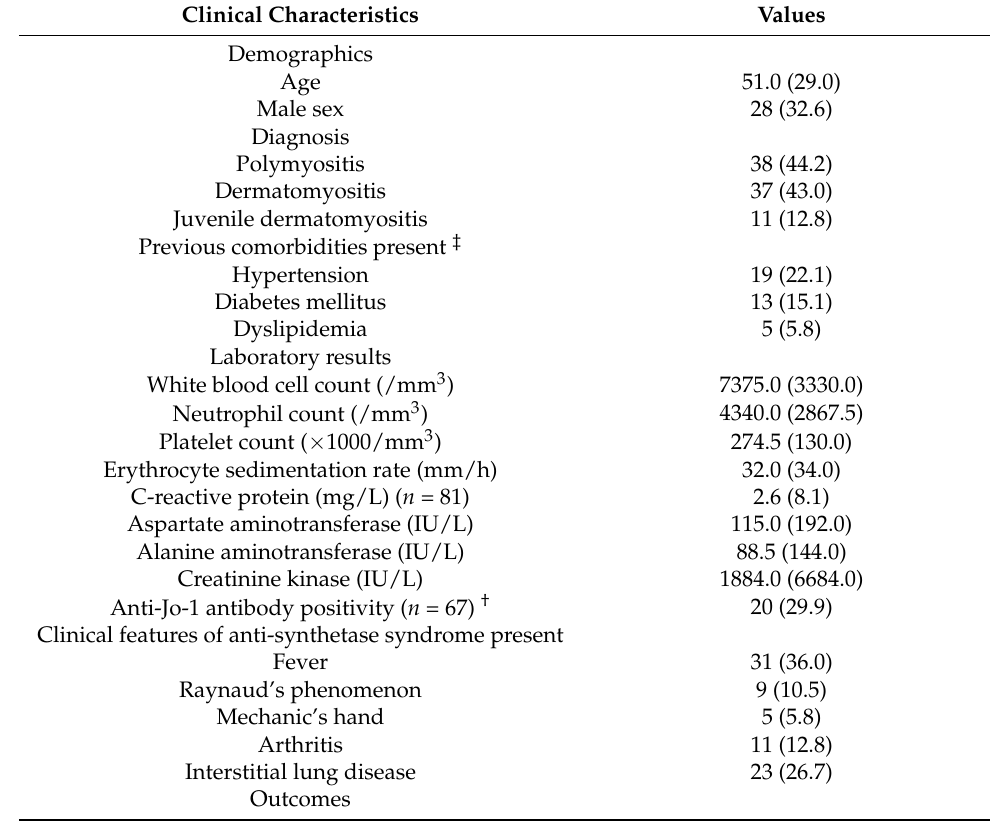
Table 1. Baseline data of the 86